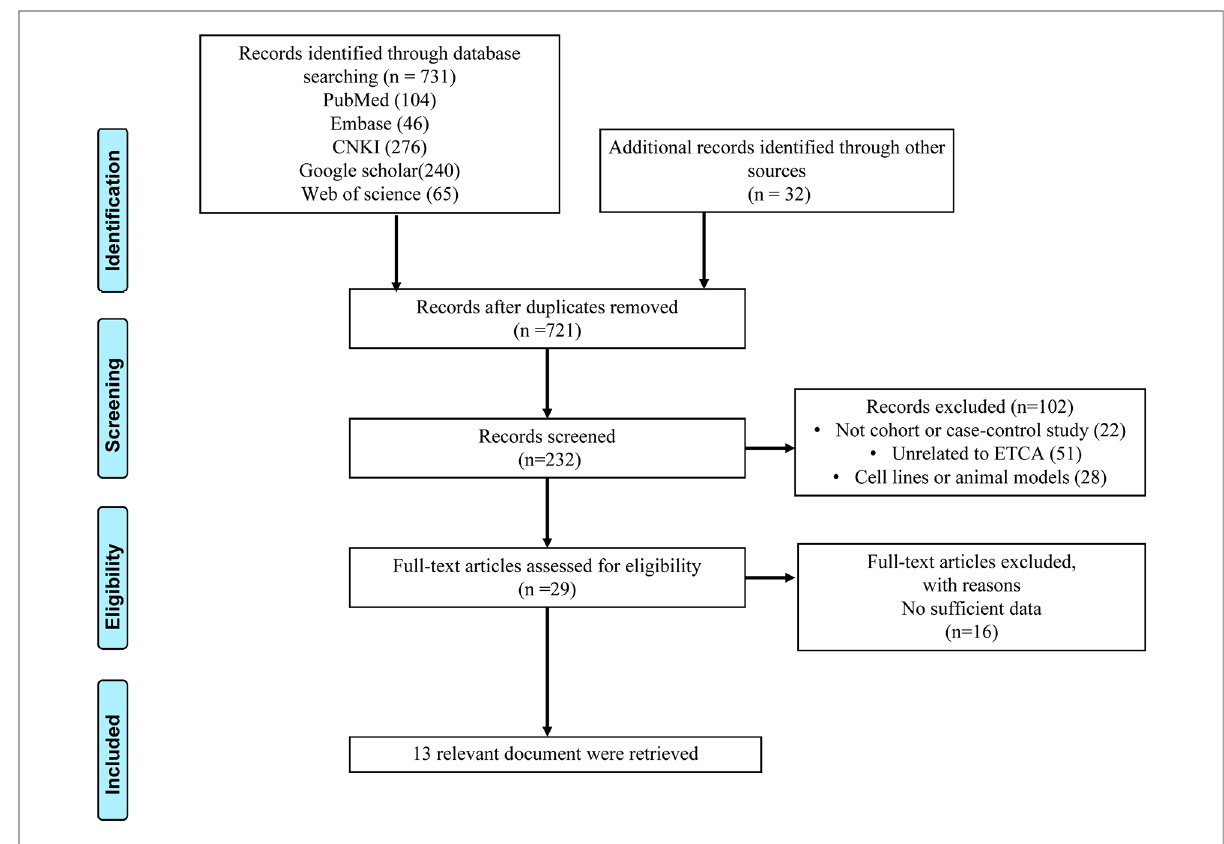
FIGURE 1 PRISMA fl ow